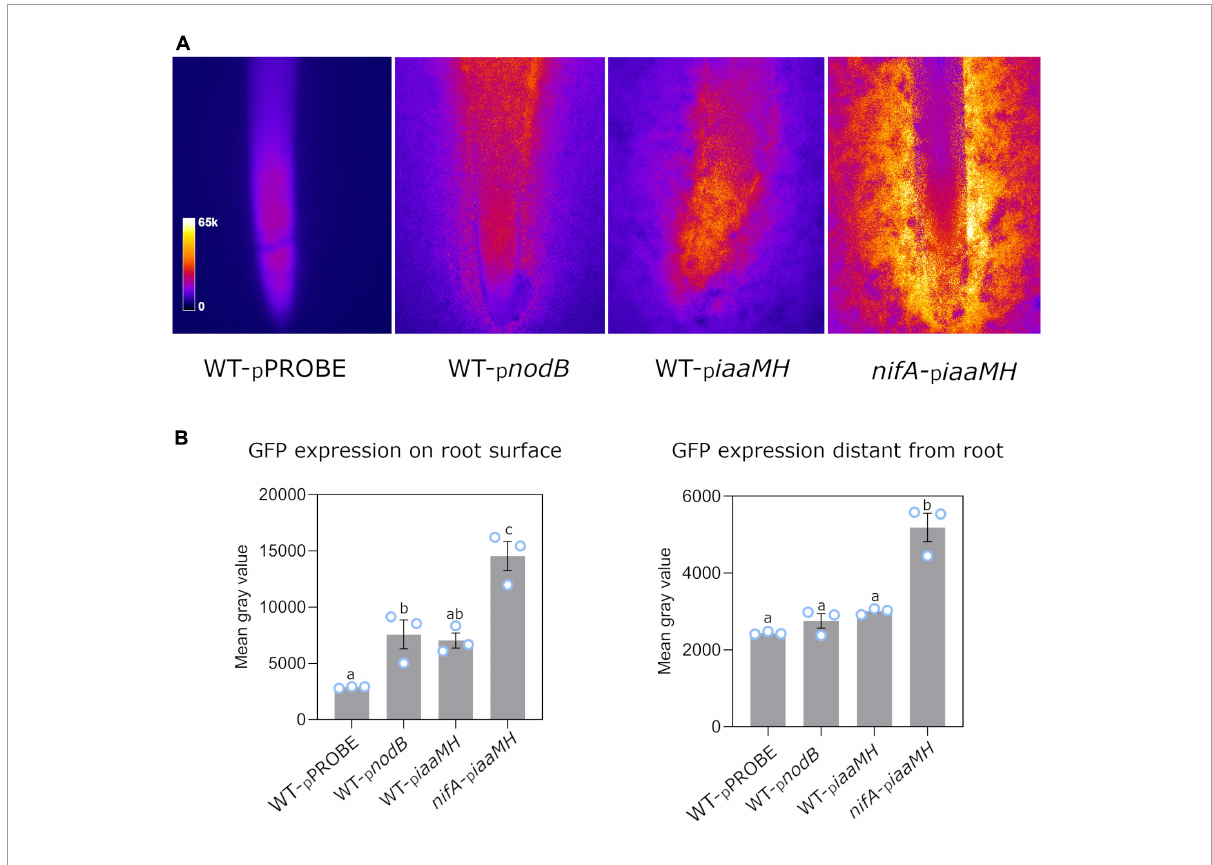
FIGURE3 NifA-dependent iaaMH-gfp expression on germinated Phaseolus vulgaris roots in Paraburkholderia phymatum STM815 wild-type (WT- p iaamH ) and in a nifA mutant ( nifA - p iaaMH ). A gfp reporter construct was used. P. phymatum wild-type containing the empty pPROBE (WT- p PROBE) and the nodB promoter sequence (WT- p nodB ) were used as a negative and a positive control, respectively. (A) Representative stereomicrographs of one of the three biological replicates inoculated per strain. Fire lookup table (LUT) indicates fluorescent signal intensity (see insert, left panel). (B) Quantitative analysis of gfp expression on P. vulgaris root surface and at 3 cm distance from the root. Blue circles represent individual data points. Error bars indicate the standard error of the mean (SEM). Significant differences between samples were analyzed with one-way ANOVA with Tukey’s test ( p -value ≤ 0.05). Same letters indicate that samples are not statistically significantly different